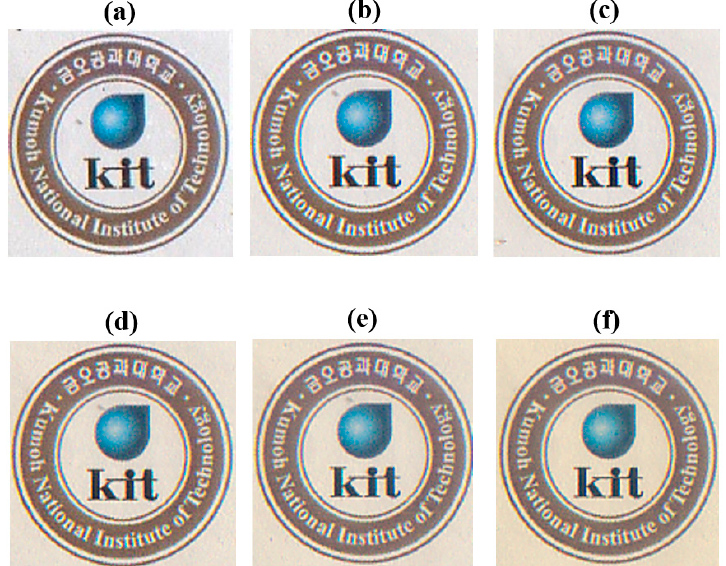
Figure 12. Photographic images of the various Co-PI hybrid films over the Kumoh National Institute of Technology logo. ( a ) 0 (pure PI), ( b ) 5, ( c ) 10, ( d ) 20, ( e ) 40, and ( f ) 50 wt % STN.